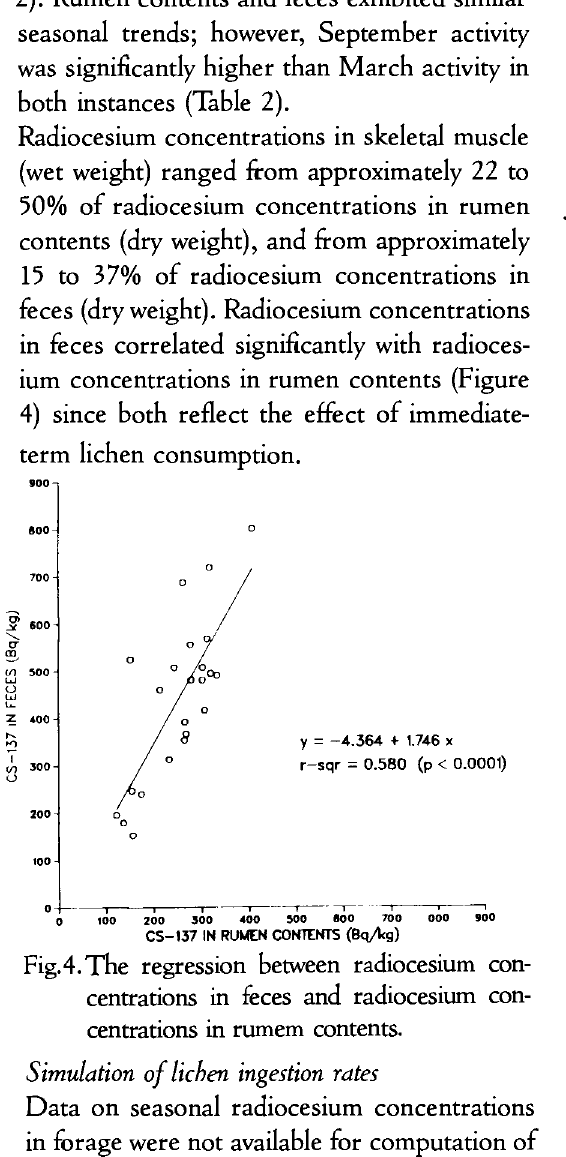
Fig.4. The regression between radiocesium con centrations in feces and radiocesium con centrations in rumem